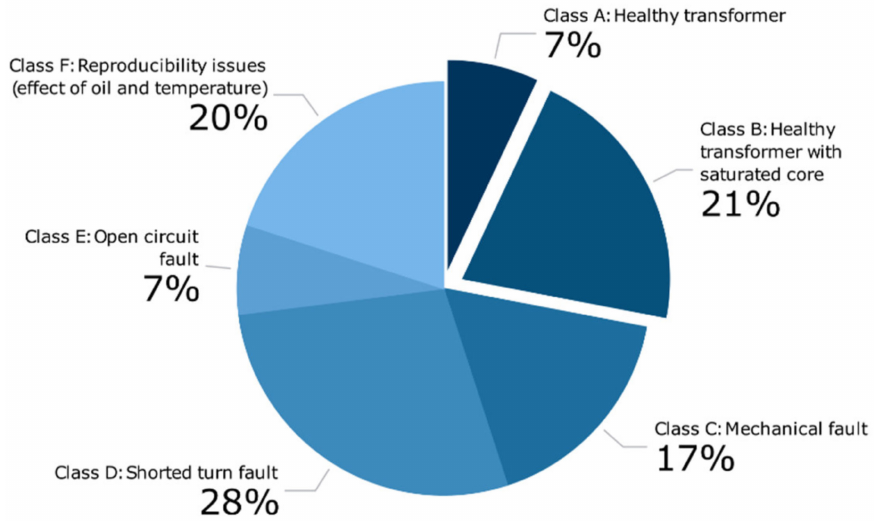
Figure 2. Breakdown of the entire database into six transformer conditions.